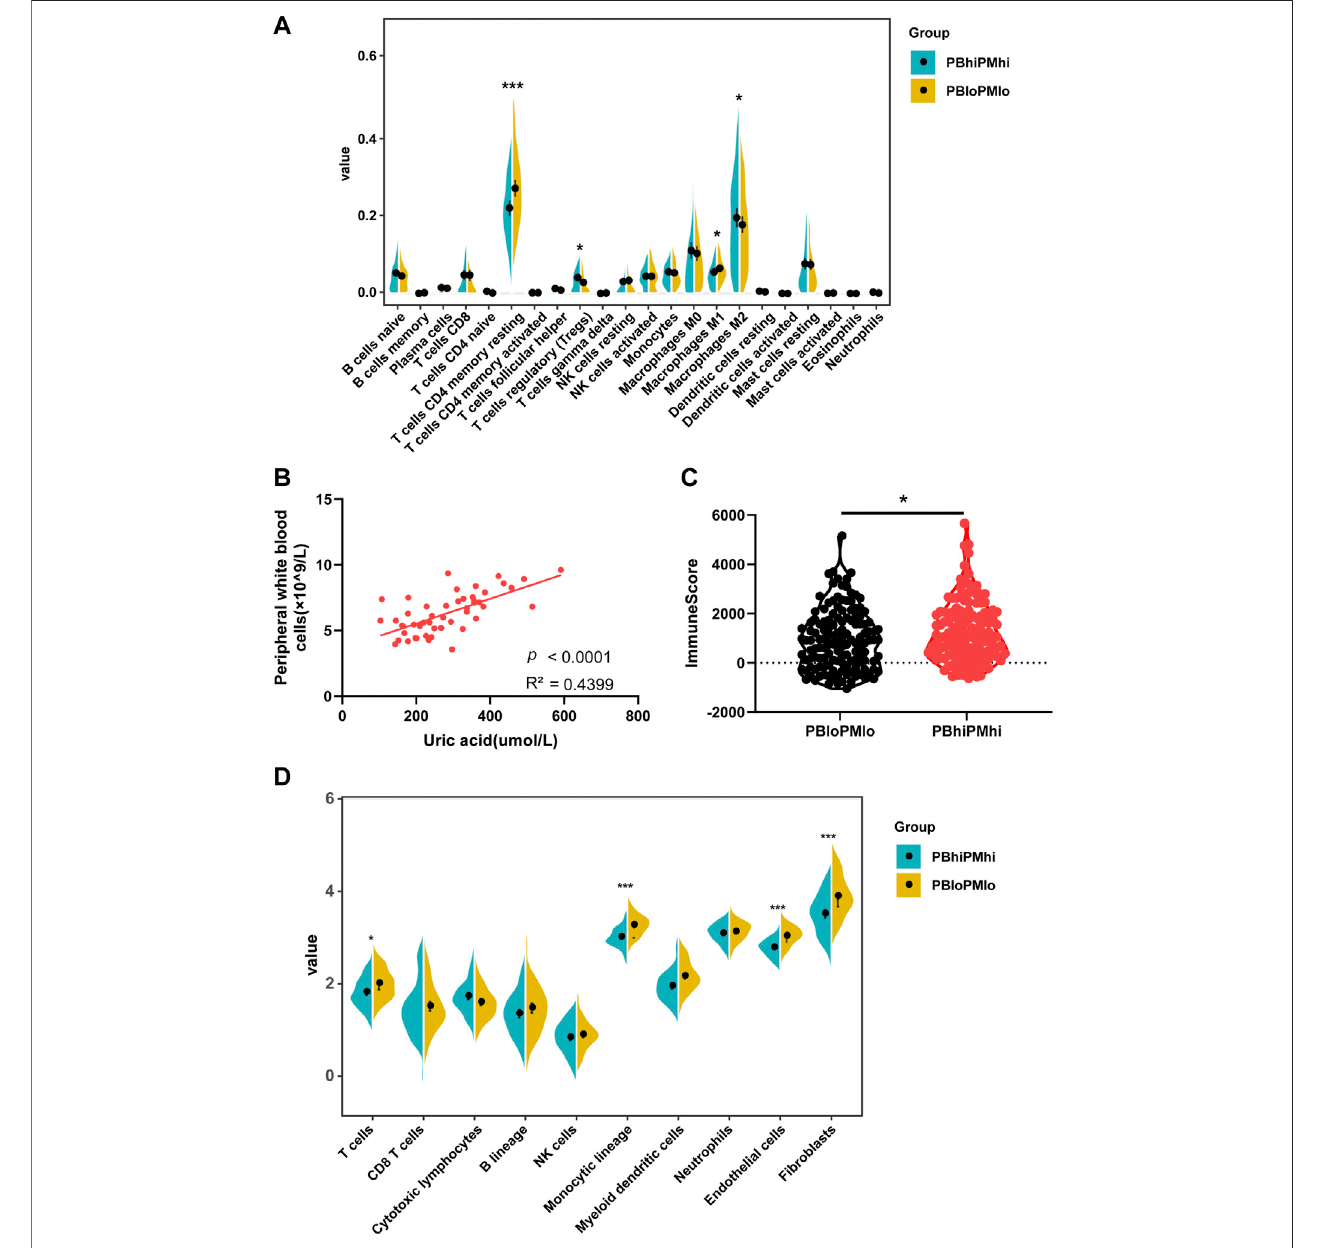
FIGURE 3 | Purine metabolism affects immune in fi ltration microenvironment in patients with HCC. (A) Violin diagram shows the proportion of 22 immune cells in HCC patients in the PBhiPMhi group and PBloPMlo group. (B) Correlation between uric acid level and peripheral blood leukocytes in HCC patients. (C – E) Estimate and MCP count algorithms to verify the immune in fi ltration between PBloPMlo and PBhiPMhi groups.